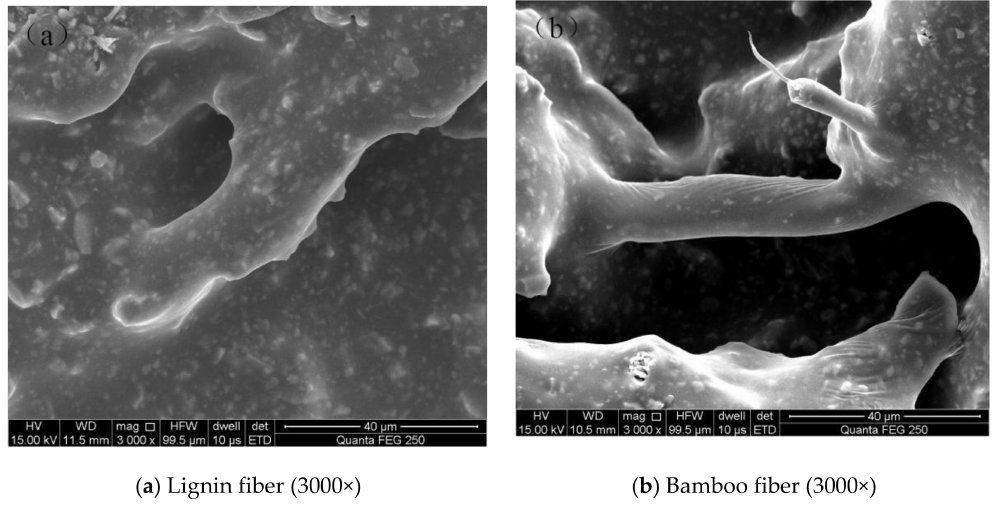
Figure 4. “Reinforcement” and “bridging” effects of two kinds of fibers in asphalt